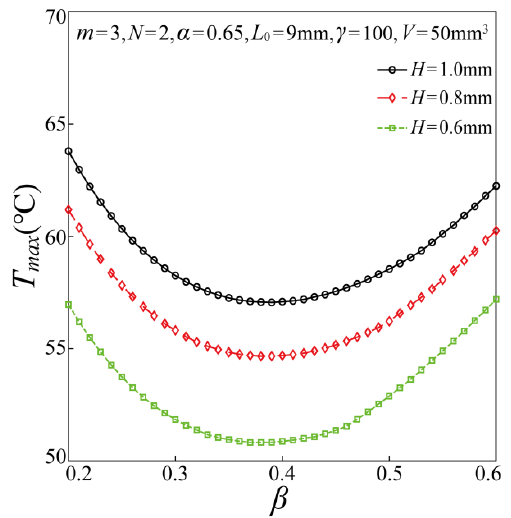
Figure 7. Effect of β with different H on the maximum temperature of the chip.